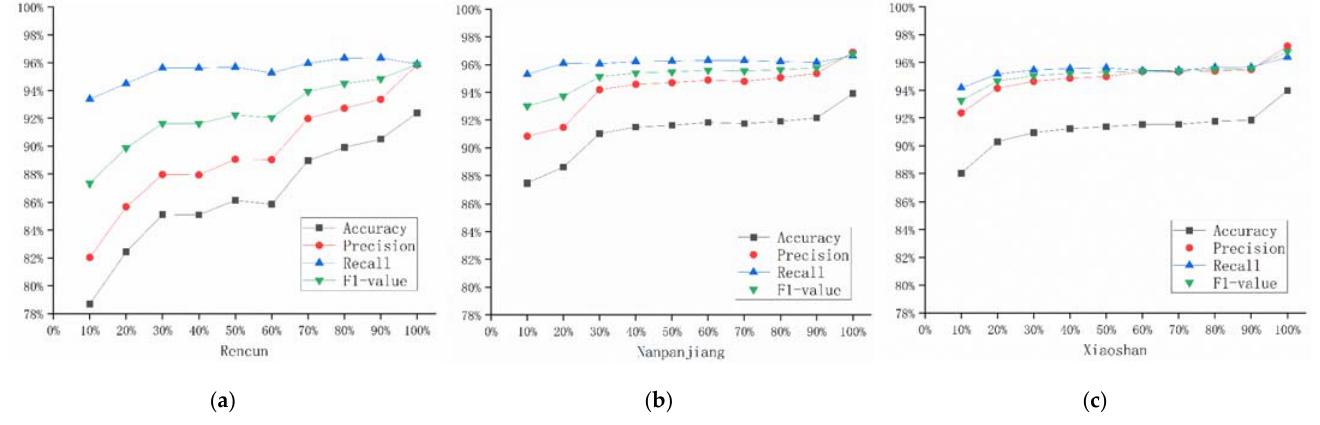
Figure 5. Variation under the different percentages of candidate term calculation range of the full text. ( a ) Rencun; ( b ) Nanpanjiang; ( c ) Xiaoshan. Note: The x -axis is the percentage of the currently calculated candidate term set in the full text, and the y -axis is the variation in accuracy.